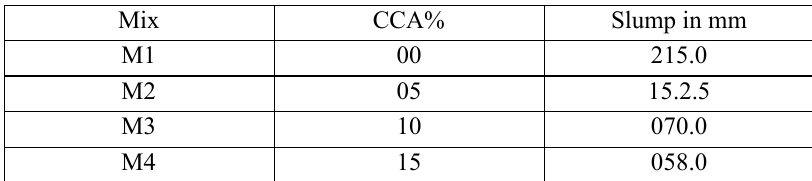
Workability of concrete.